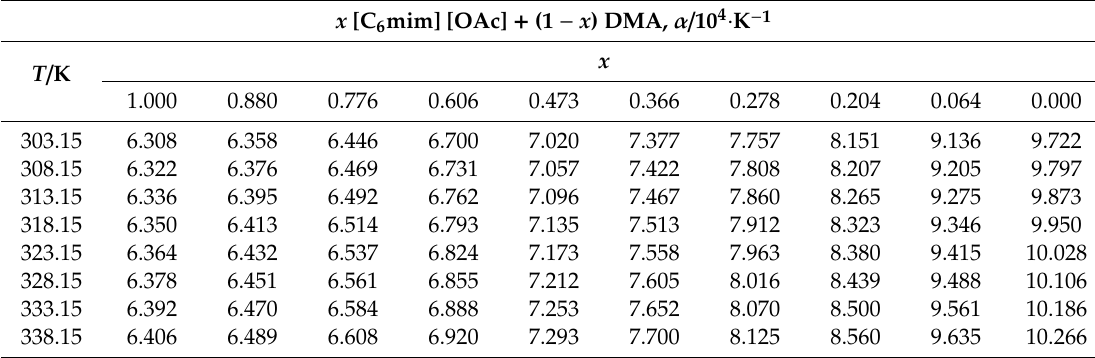
Table 6. Thermal expansion coe ffi cients of [C 6 mim] [OAc] with organic solvent of DMA.